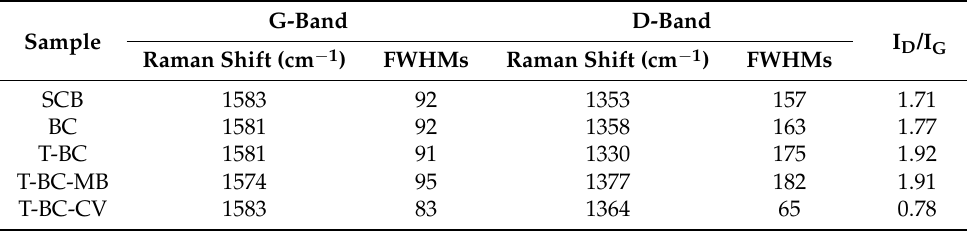
Table 1. The D and G-band shifts, FWHMs, and I D /I G ratios.